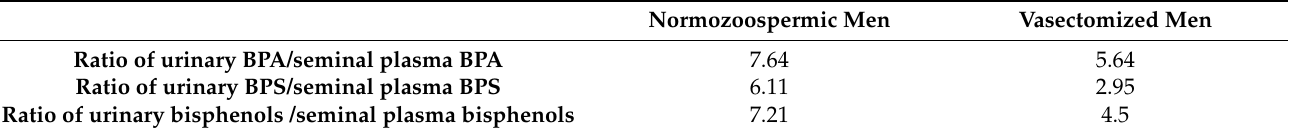
Table 1. Relative ratio of bisphenol content in urine and seminal plasma in men with normozoosper- mia and in men after vasectomy.